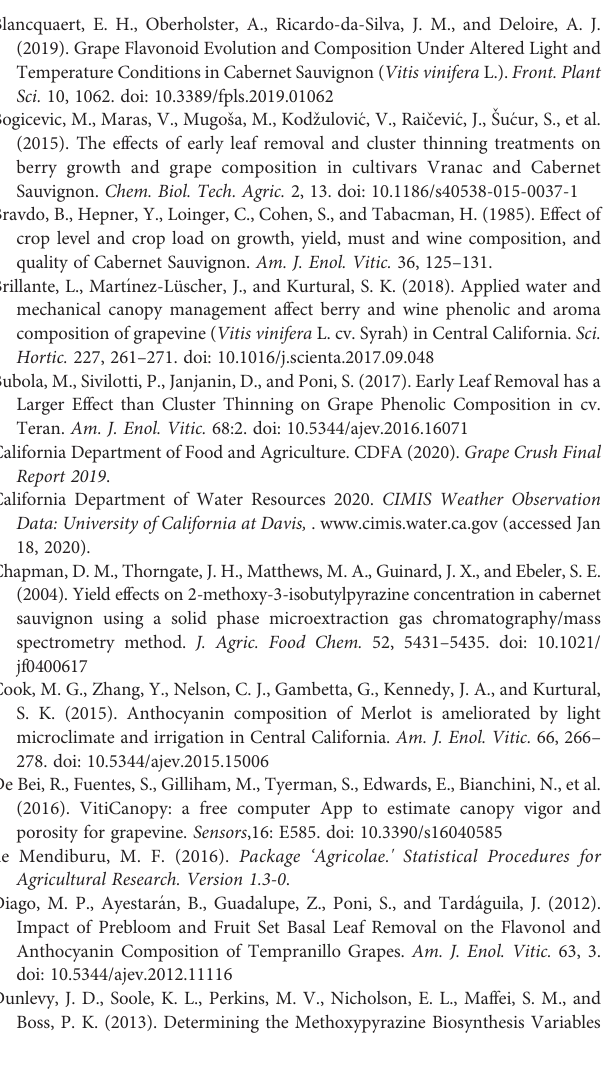
practices (UNT: Untreated, LR: Leaf removal, ST: Shoot thinning and LRST: LR and ST combined). Cluster temperature means separated by Duncan's new multiple range test (at P = 0.05). Within columns, means followed by different letters are signi fi cantly different as affected by the canopy management practices of leaf removal and shoot thinning and their interactions. FIGURE S3 | Relationship between grape skin anthocyanin (A) and IBMP (B) content (mg and pg per berry, respectively) and increasing exposure (% of kaempferol, Mart ı ́ nez-Lüscher et al., 2019) in Cabernet Sauvignon subjected to different canopy management practices (UNT: Untreated, LR: Leaf removal, ST: Shootthinning andLRST: LR andST combined). Blacklines are the breakingpoints determined through segmented regression. TABLES1 | Effectofthe different degreeof exposure ontheskin fl avonoid content of Cabernet Sauvignon and Petit Verdot berries collected from different orientations (Interior, Exposed from the West side of the canopy, Exposed from the East side and Overexposed from the East side of the canopy) in Oakville, CA in 2017. Values represent means separated by Kruskal-Wallis test (at p = 0.05). Within columns, means followed by different letters are signi fi cantly different as affected by the combination of degree of exposure and cultivar